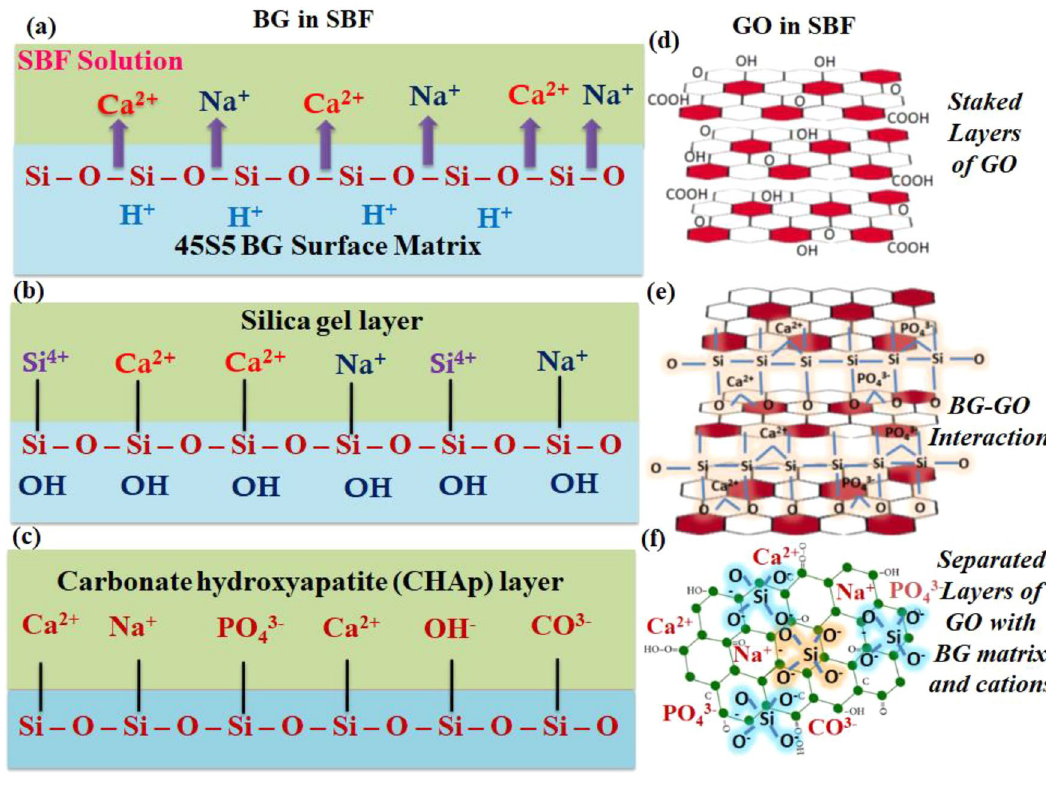
Figure 12. Schematic representation of structural modifications of BG and GO immersed in SBF solution; ( a ) BG immersed in SBF with cationic ion exchange, ( b ) formation of Si layer by dissolving Ca and P ions, ( c ) CHAp layer formation on the BG surface, ( d ) stacked layers of GO in SBF solution, ( e ) GO sheets interact with BG matrix and cations in SBF via hydroxy and carbonyl groups, which reduces the interplanar distance and weakens the van der Waals force between the sheets, ( f ) separated GO stack into a single layer with BG matric interconnection.